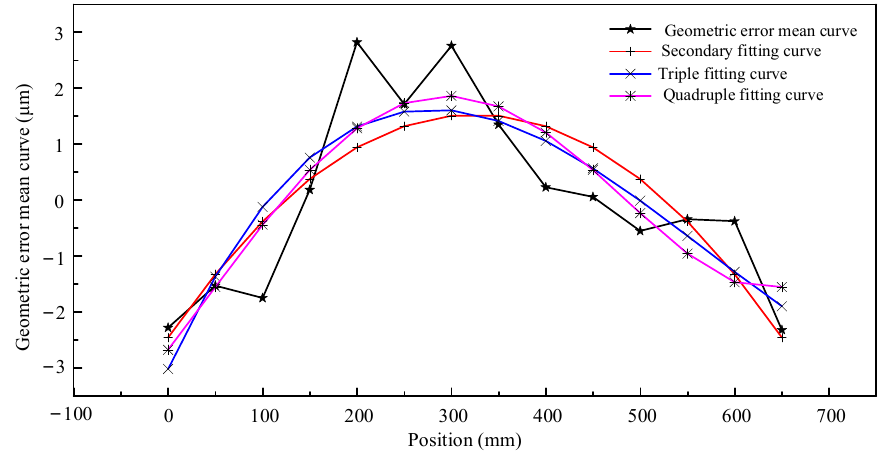
Figure 12. Comparison chart of thermal error time positions with different motion parameters.